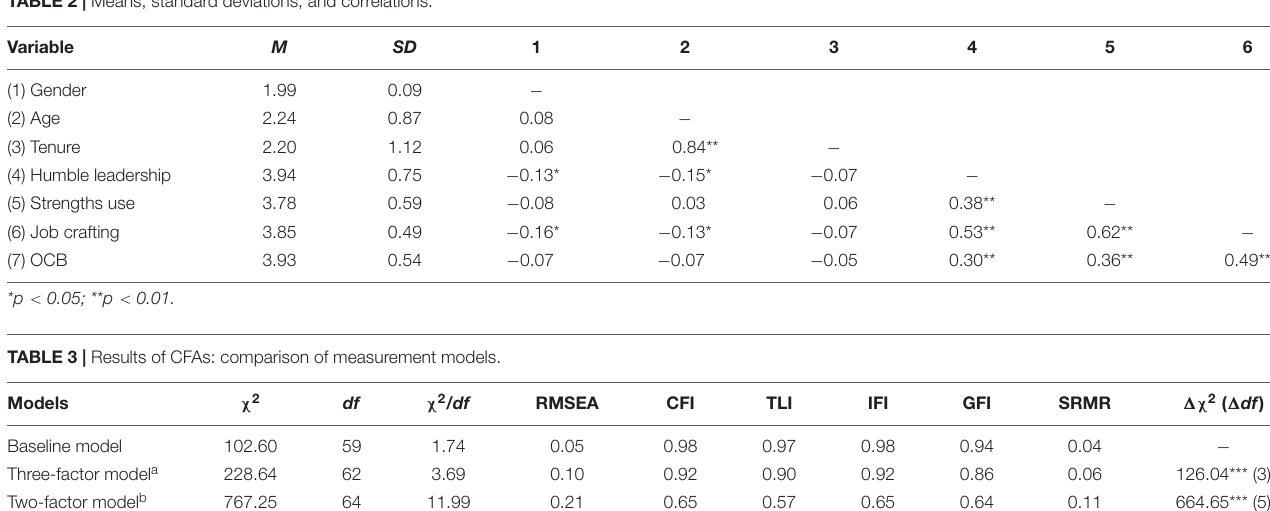
TABLE 2 | Means, standard deviations, and correlations.